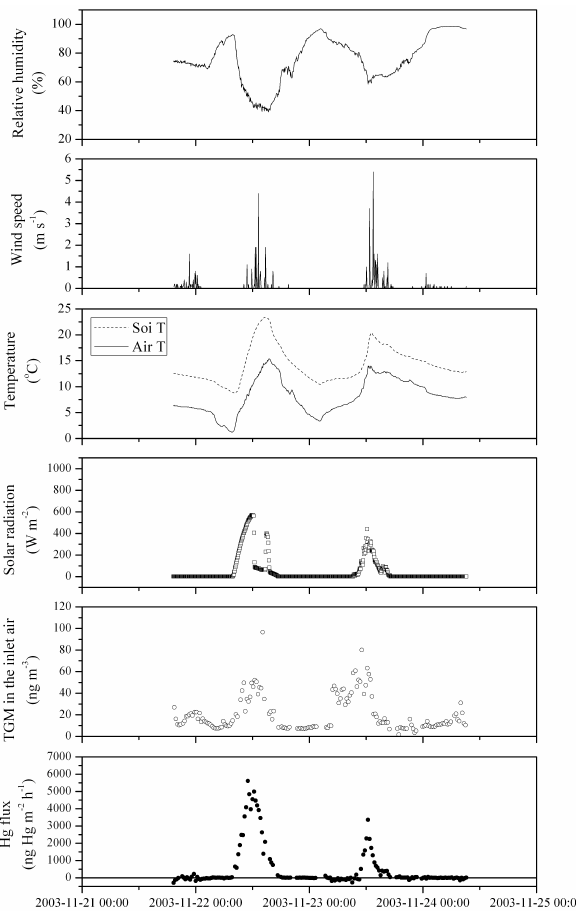
Fig. 4. Mercury surface-air fluxes at un-covered MSW site of G-Y landfill: the contribution of high mercury content in MSW to the mercury emission rate.